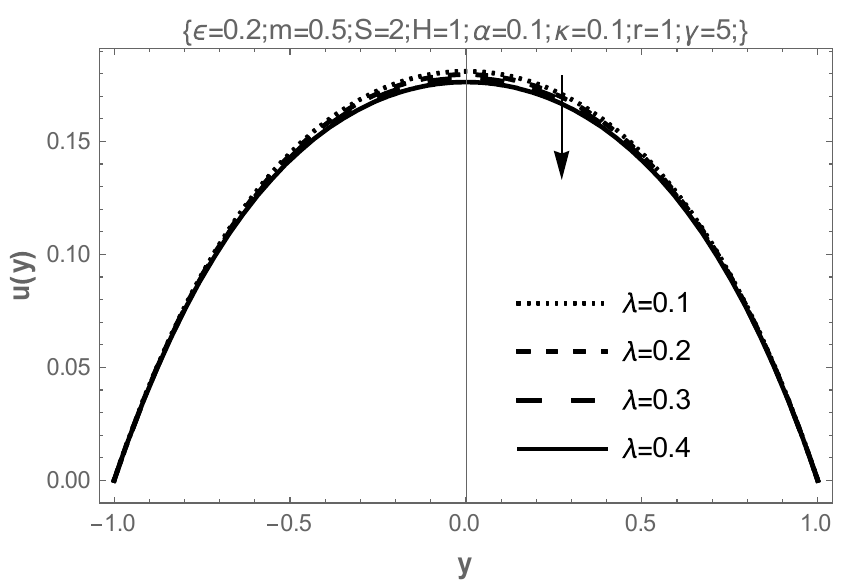
Figure 2. Effect of the Frank–Kameneskii parameter on flow velocity.